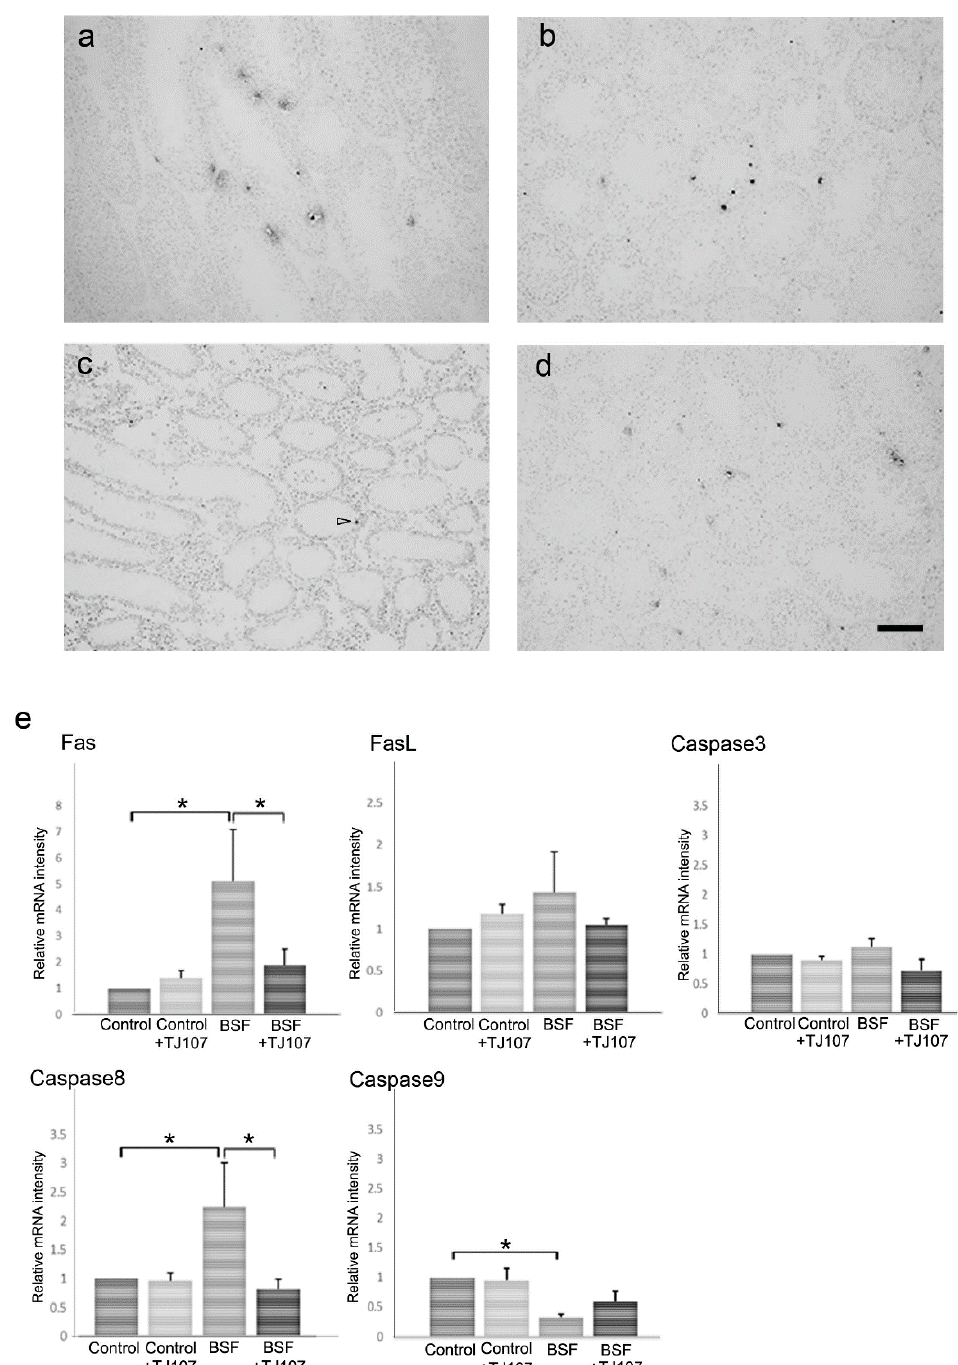
Figure 4. Histological detection of TUNEL staining in testicular sections of mice from the control ( a ), control+TJ107 ( b ), BSF ( c ), and BSF+TJ107 ( d ) groups at day 120. Ten testes from each group were examined. Dark brown spots indicating TUNEL-positive nuclei of apoptotic germ cells are seen. Some TUNEL-positive germ cells are detected in the seminiferous tubules in the control ( a ), control+TJ107 ( b ), and BSF+TJ107 ( d ) groups at day 120. Most germ cells are destroyed at day 120 in the BSF group; thus, TUNEL-positive cells (arrowhead) are hardly detected ( c ). Bar: 40 µm. ( e ) Expressions of Fas, FasL, Caspase3, Caspase8, and Caspase9 in testicular tissues of mice from each group ( n = 10). Asterisks indicate p < 0.05.